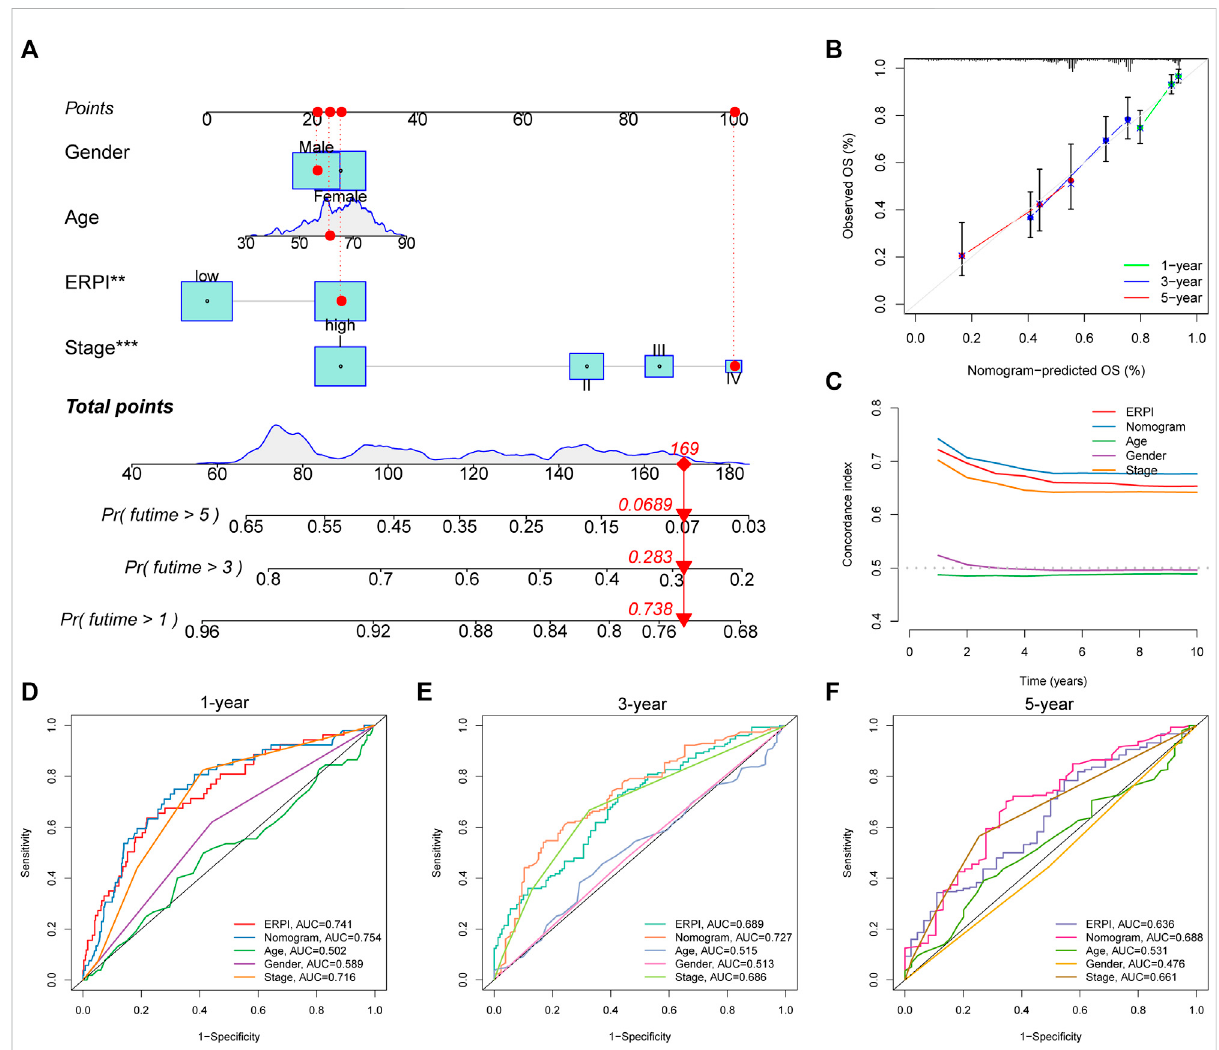
FIGURE 5 Establishment and validation of the nomogram. (A) Nomogram incorporating ERPI and clinicopathological variables. (B) Calibration curves of the nomogram. (C) C-indexes of the nomogram, ERPI, and clinicopathological variables. (D) ROC curves of the nomogram, ERPI, and clinicopathological variables at 1 year. (E) ROC curves of the nomogram, ERPI, and clinicopathological variables at 3 years. (F) ROC curves of the nomogram, ERPI, and clinicopathological variables at 5